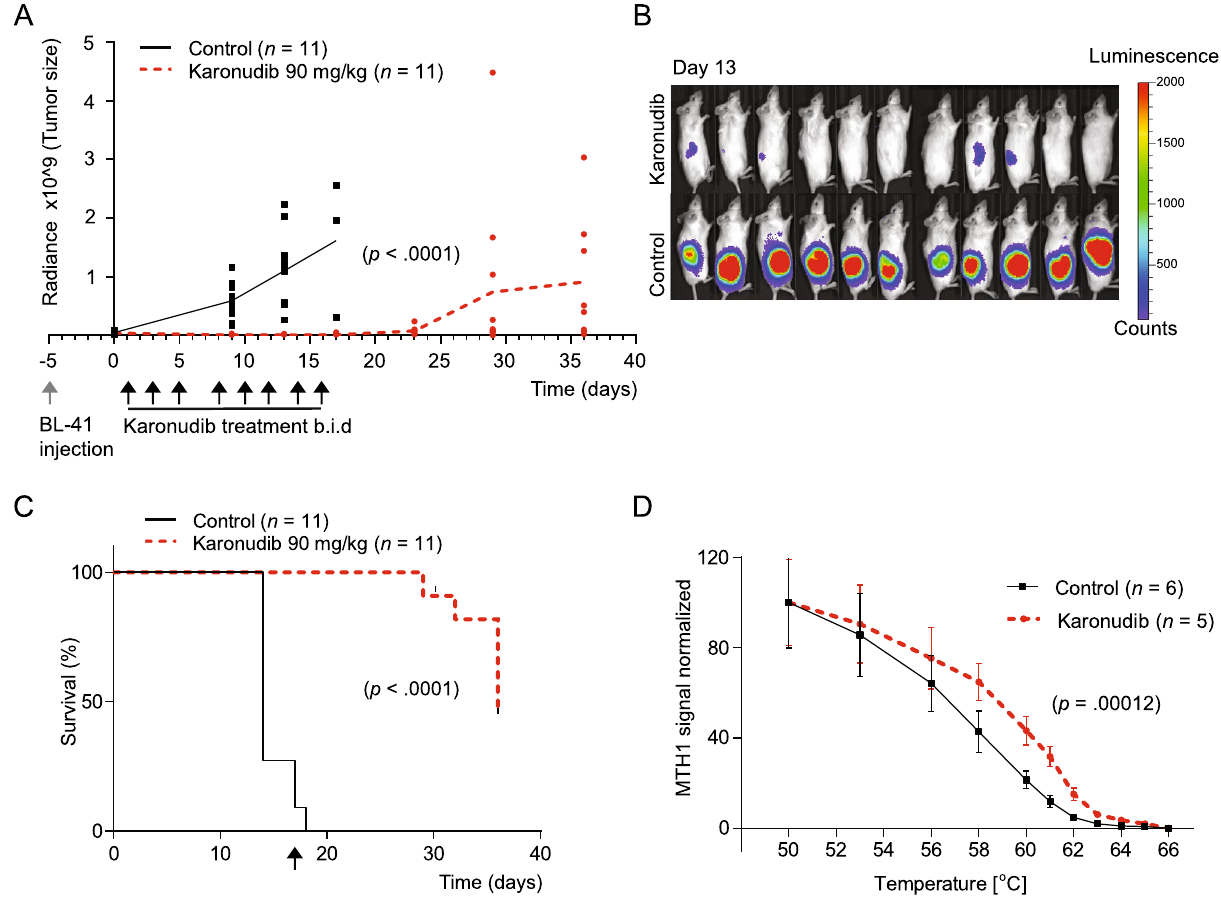
Figure 5. Karonudib has a strong anti-tumor effect in vivo . ( A ) Tumor growth of BL-41-luc cells was monitored with IVIS luminescence measurements (physical units of surface radiance (photons/s/cm 2 /st)) at day 0, 9, 13, 17, 23, 29 and 36 after treatment start. Treatment was initiated 6 days after inoculation, and karonudib was given per os, b.i.d, 90 mg/kg three times a week for 16 days. Tumor growth was significantly decreased in mice treated with karonudib already at day 9, 13 and 17 compared with treatment start ( P < 0.0001 for all time points). There was a significant difference ( P < 0 . 0001) between treatment and vehicle both 9 and 13 days after treatment start (unpaired two-tailed t-test with Welsh’s correction). ( B ) IVIS image of animals at day 13. ( C ) Kaplan–Meier is based on tumor size (> 2 cm 3 or 2 cm length in one direction). Median survival was 14 vs. 36 days in control vs. karonudib treated mice ( P < 0.0001, Log-rank test). Arrow indicates end of treatment. ( D ) In vivo target engagement of karonudib to MTH1 shown by CETSA. Vehicle treated mice were randomized and then given karonudib (90 mg/kg) or vehicle 18 h and 4 h prior to euthanization and dissection of tumor tissue. Melting curve for MTH1 with a significant T m shift of 2.55°C is shown ( P = 0.00012, karonudib treated ( n = 5), vehicle ( n = 6)) measured at 50% MTH1